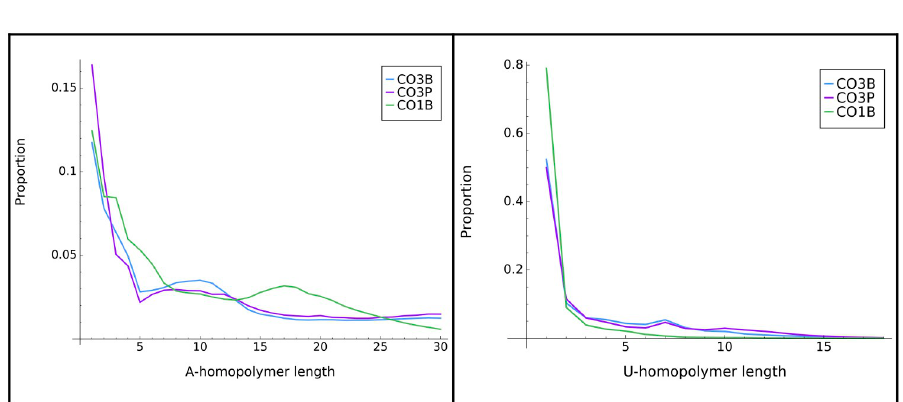
Fig 2. Homopolymer distribution in tails. Distribution of lengths of A-homopolymer (left) and U-homopolymer (right) found within tail populations of the three transcripts that are only expected to possess the primarily homopolymer-containing in-tails. Y axis scales differ in the left and right